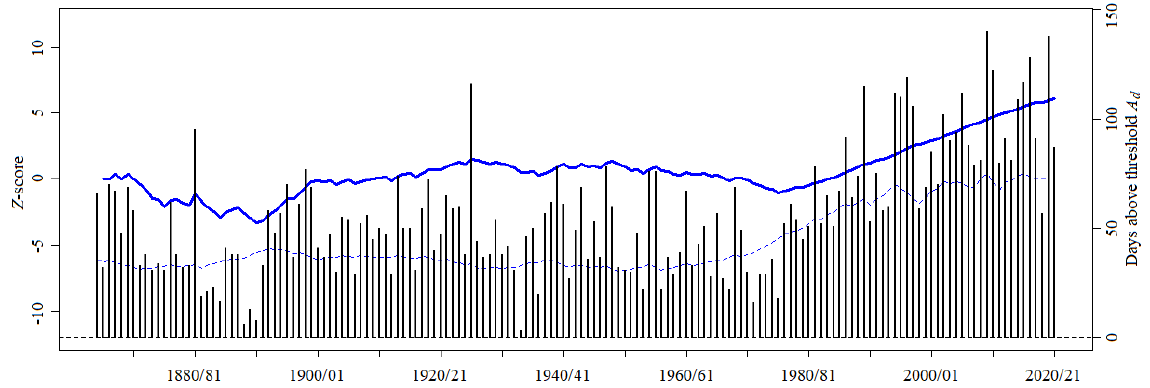
Figure 12. Sequential Mann–Kendall test applied to the annual number of Tmin heatwave days from 1864/65 to 2020/21. The progressive u ( t ) (solid blue line) and retrograde u (cid:48) ( t ) (dashed blue line) trend series, i.e., the Z-scores, are derived from the number of Tmin heatwave days—daily Tmin above A d —in each hydrological year (black